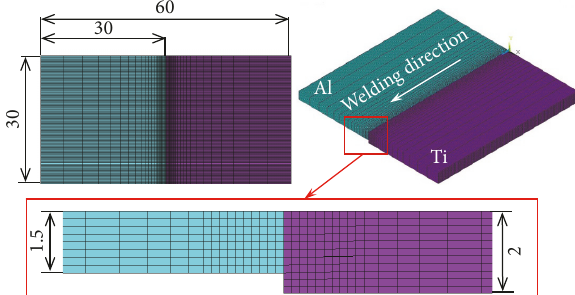
Figure 1: FEM model of welded sample with the detail of generated mesh.